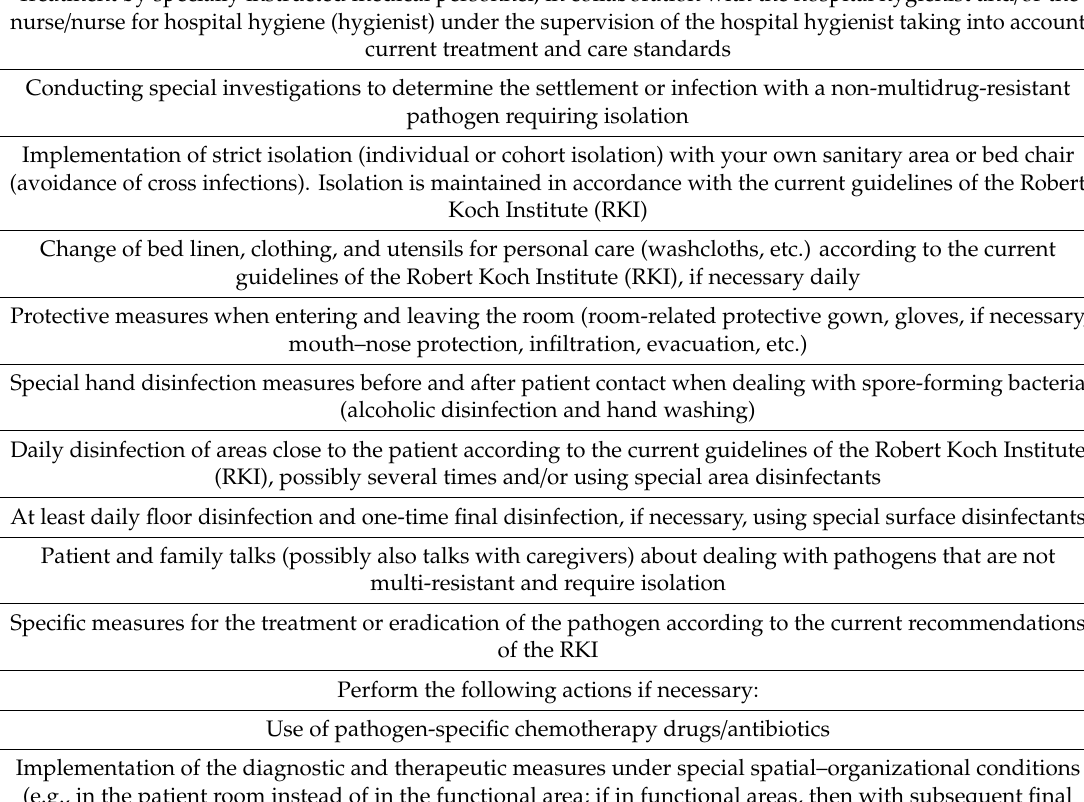
Table 4. Complex treatment for infection with pathogens requiring isolation OPS 8–98